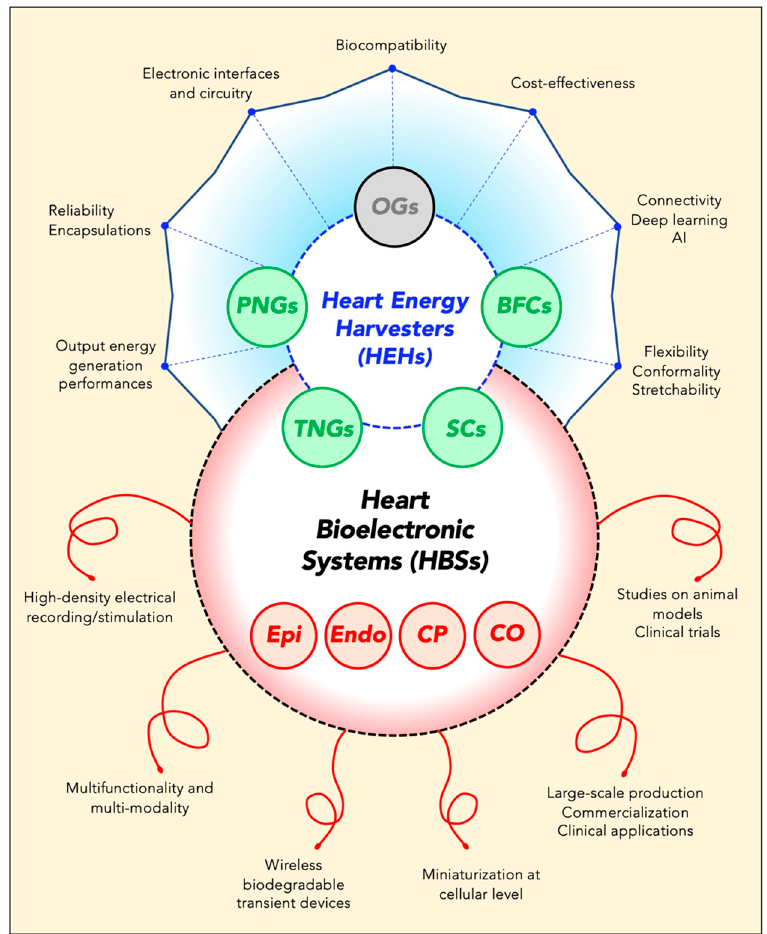
Figure 12. Illustrations of challenges and issues to be solved for the future employment of heart energy harvesters (HEHs) and heart bioelectronic systems (HBSs). OGs: oscillator generators; PNGs: piezoelectric nanogenerators; TNGs: triboelectric nanogenerators; SCs: solar cells; BFCs: biofuel cells; Epi: epicardial bioelectronics; Endo: endocardial bioelectronics; CP: cardiac patch; CO: cardiac organoids.